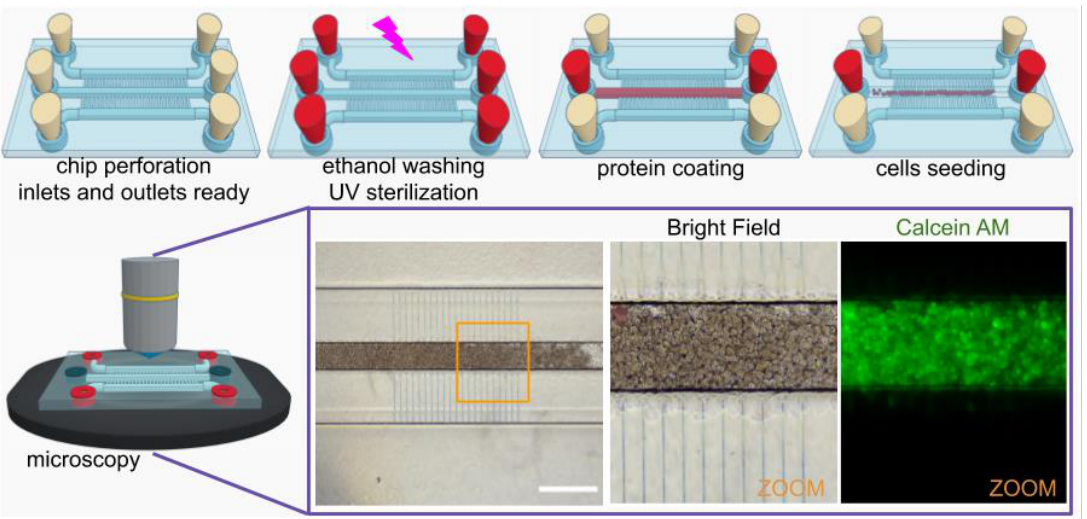
Figure 8. Culture of HepG2 cells inside the central channel with nutrients diffusing from side channels through the lateral high-resolution microchannels. The images were captured with a fluorescence microscope for Calcein AM stained HepG2. Scale bar: 500 µm.